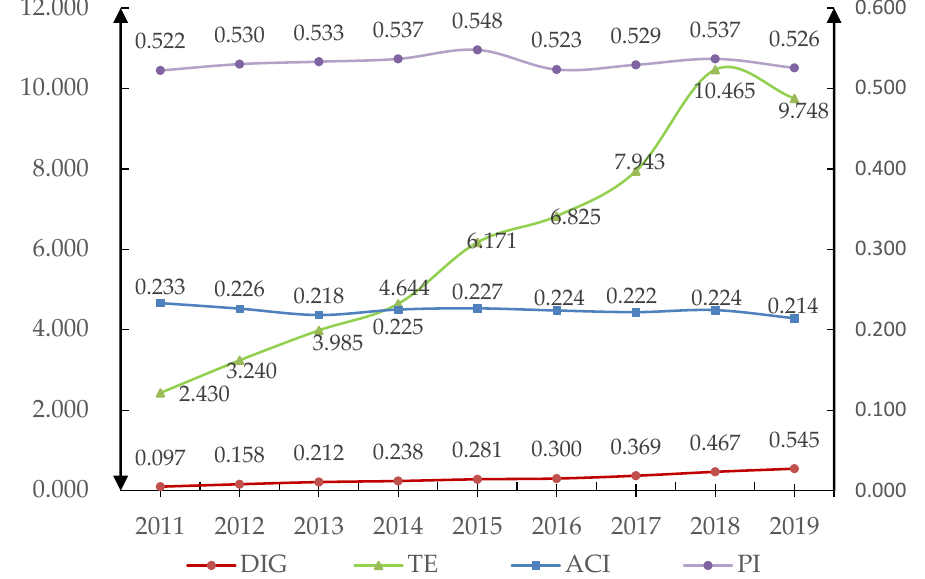
Figure 2. Time evolution diagram of China’s agricultural carbon emissions, digital economy, agricultural technology progress, and the proportion of crop production value.